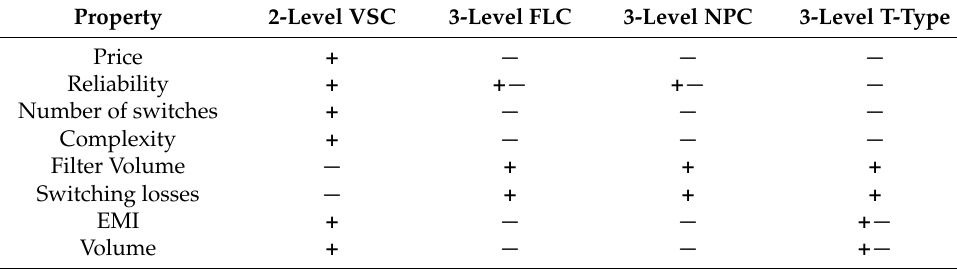
Table 2. Comparison of basic advantages of the analyzed AC/DC